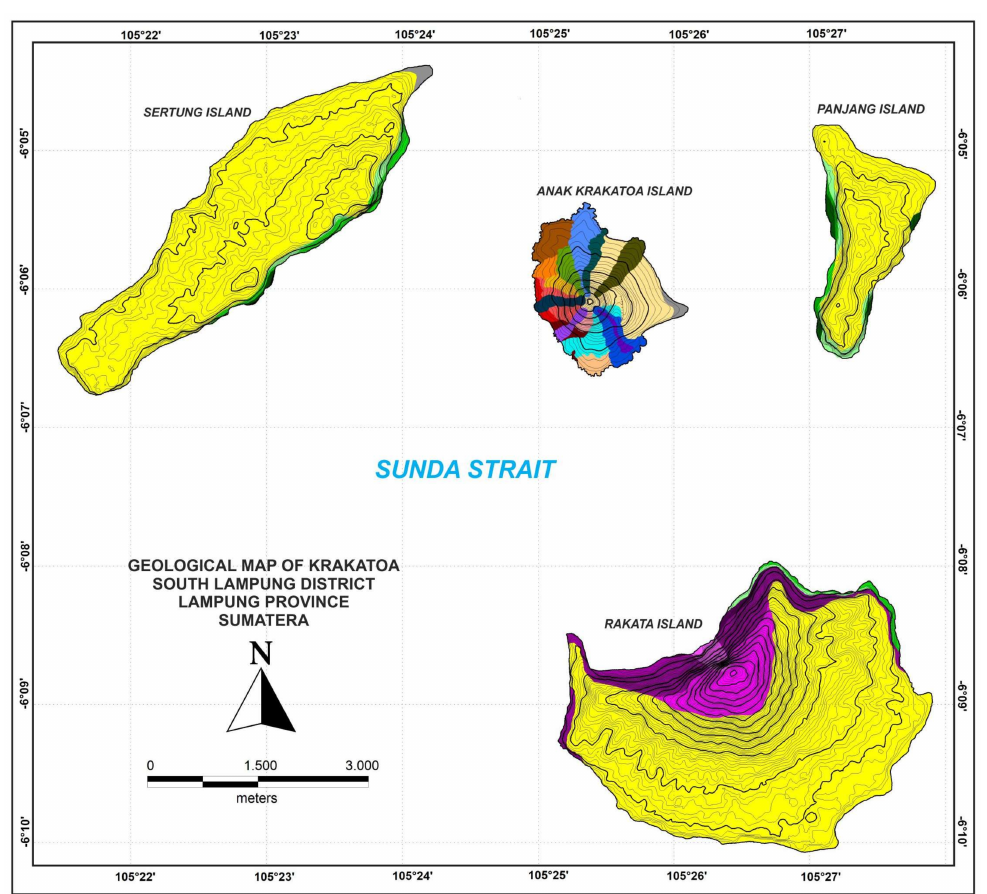
Figure 2. Geological map of the Krakatoa complex. See Figure 3 for explanation of